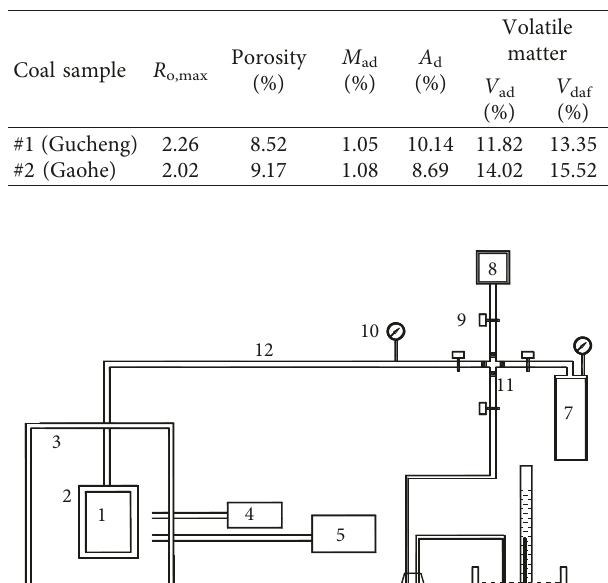
Table 1: Proximate analysis, porosity, and vitrinite reflectance of the coal samples.